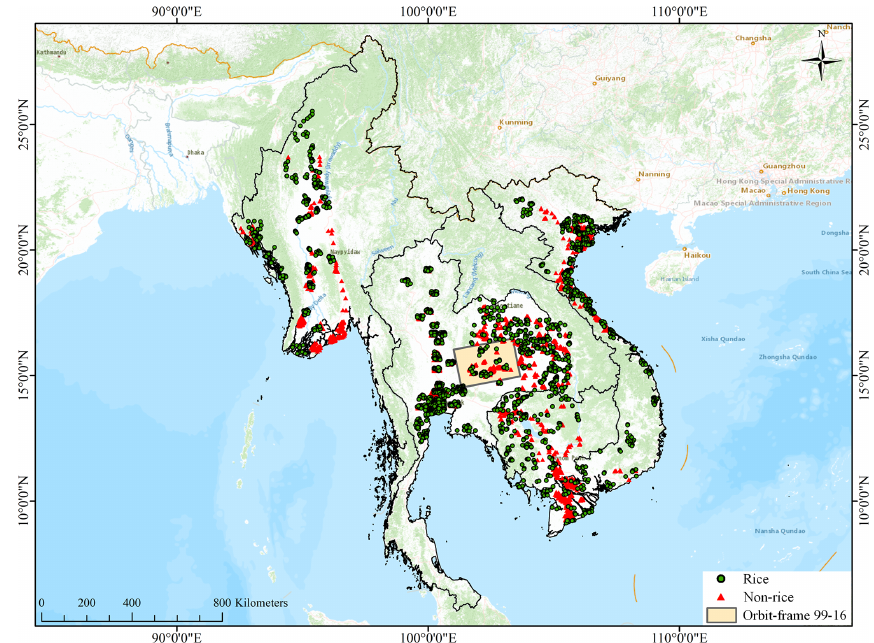
Figure 1. Location of the study area. The Sentinel-1 data with orbit frame 99-16 were used for the training samples, and the rice and non-rice flags show the distribution of the validation sample set. The base map is from